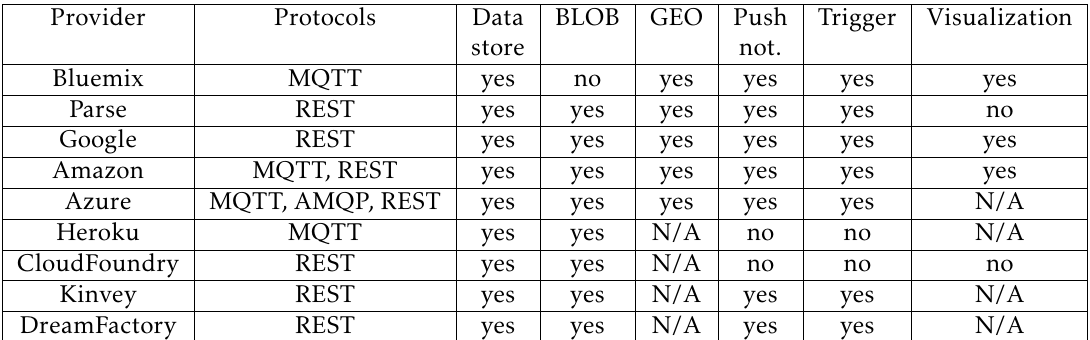
Table 3. IoT features of cloud